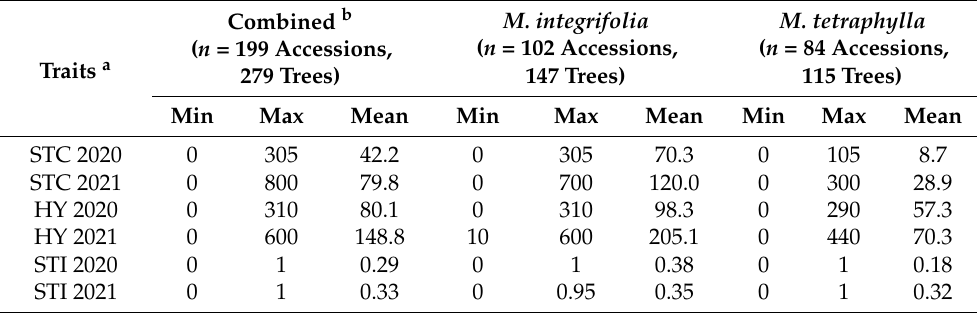
Table 2. Summary statistics of raw, untransformed phenotypes for traits analysed in GWAS in three panels.